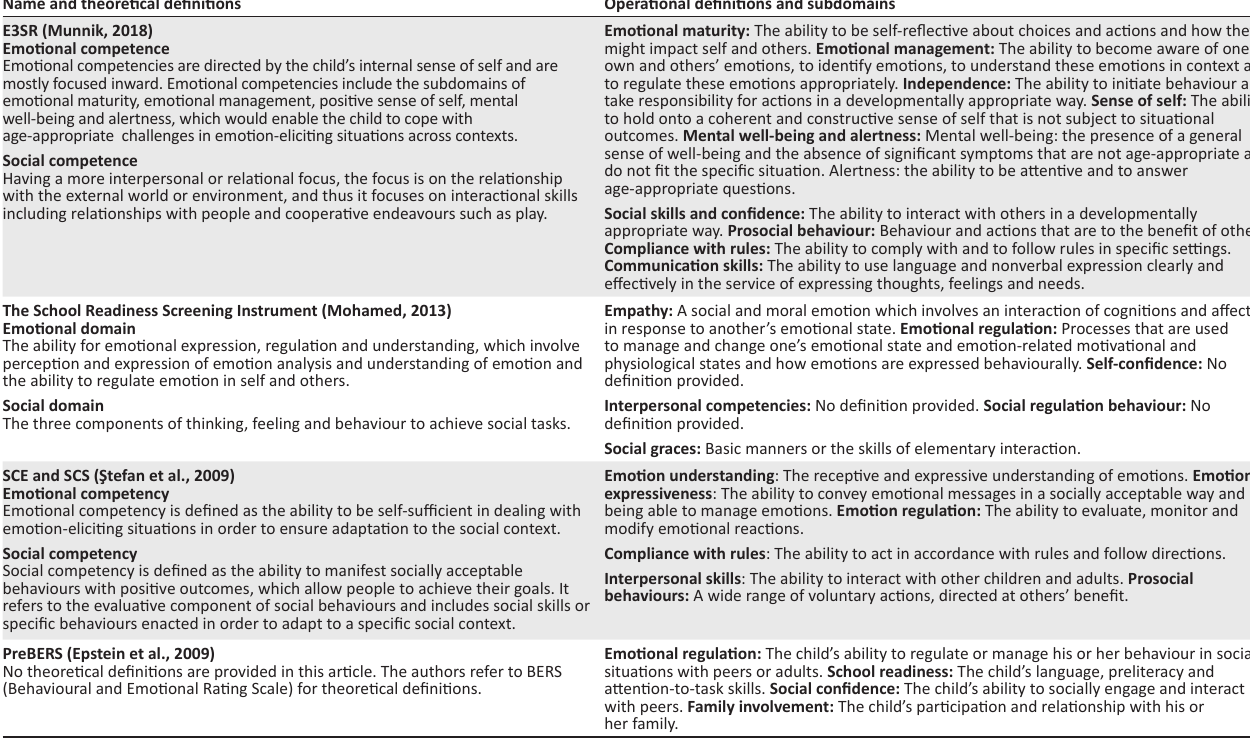
TABLE 1: Theoretical and operational definitions. Name and theoretical